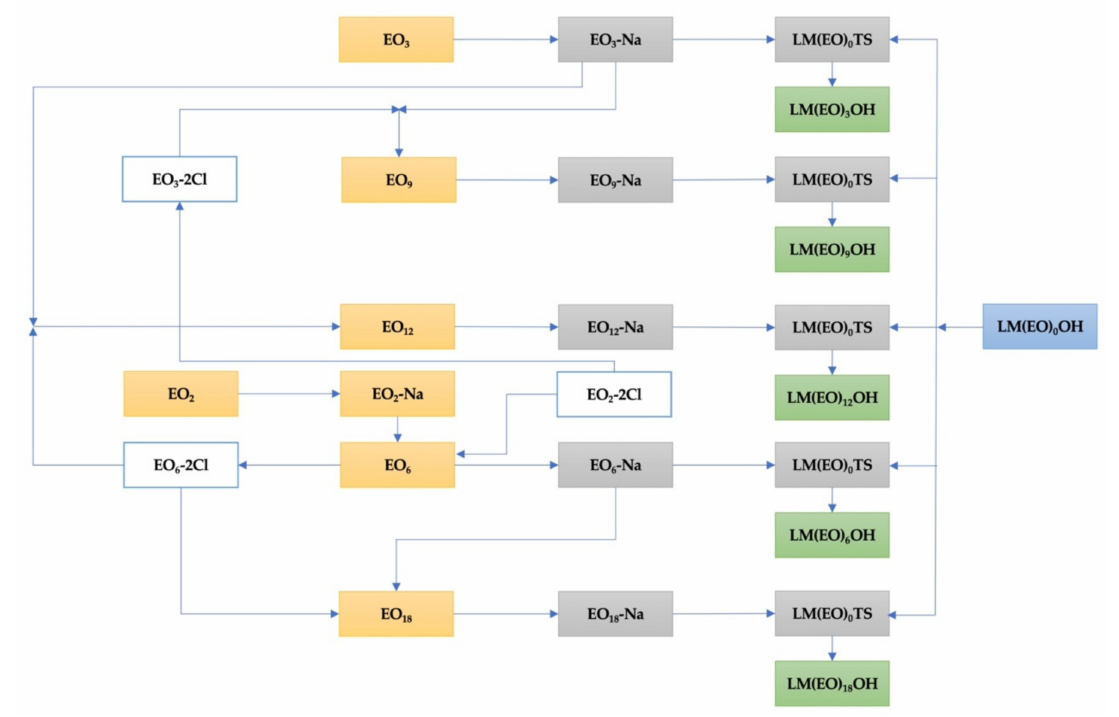
Figure 4. The step-by-step structuring scheme of homogeneous lauryl/myristyl 7/3 polyethyleneoxy n = 3, 6, 9, 12, 18 alcohols, where: EO n —homogeneous polyethylene glycols n = 3, 6, 9, 12, 18; EO n -Na—monosodium homogeneous polyethylene glycols; (EO) n -2Cl—dichlorinated homogeneous polyoxyethylene n = 3, 6, 9, 12 chains; LM(EO) n OH— homogeneous lauryl/myristyl 7/3 polyethyleneoxy n = 3, 6, 9, 12, 18 alcohols; LM(EO) n TS—tosylated homogeneous lauryl/myristyl 7/3 polyethoxylated n = 3, 6, 9, 12, 18